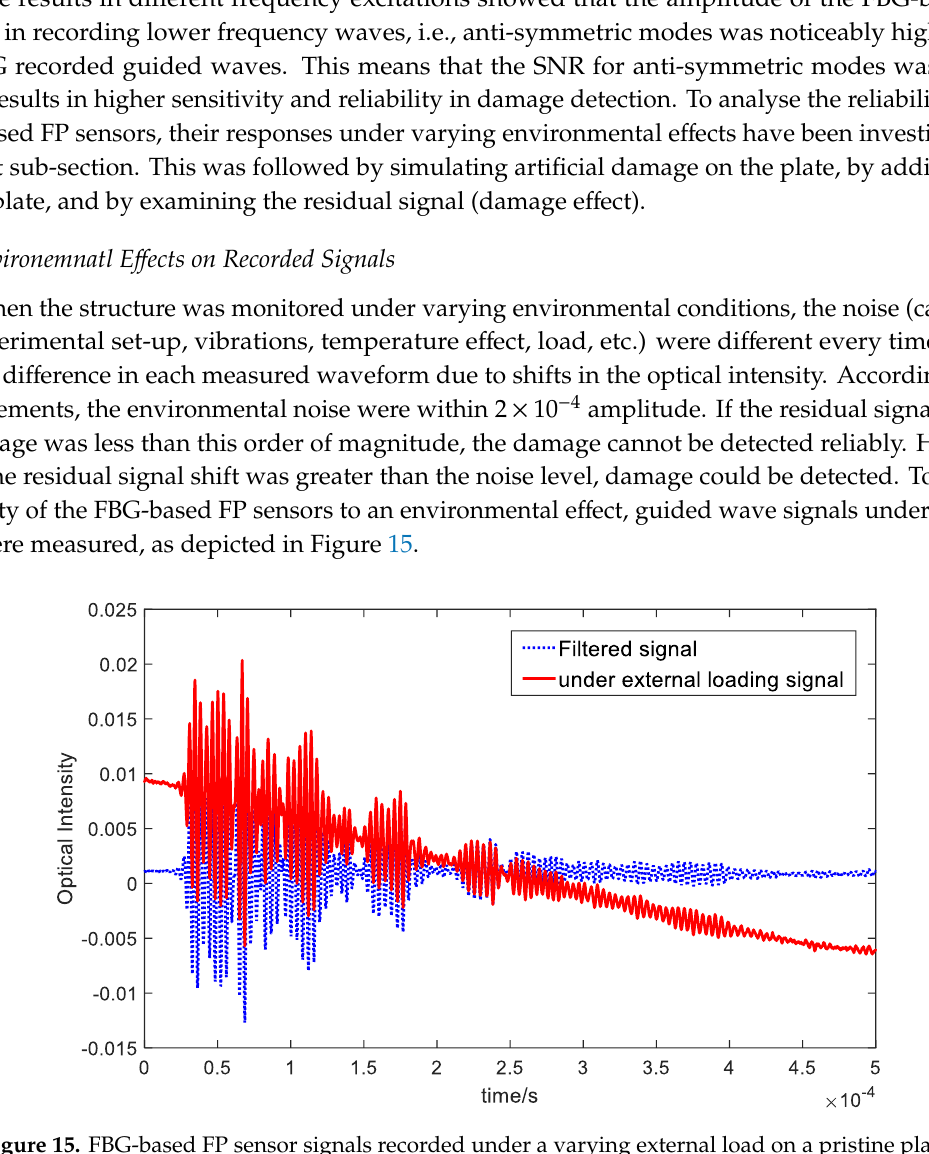
( b ) FBG sensor signal Figure 16. Processed data comparison between different environments. 4.6. Signal Acquisition – Simulated Damage To study the sensitivity of the FBG-based FP sensors in detecting damage, their response under artificial damage were recorded and compared to the FBG sensor signals (which is the conventional hybrid set up). In this paper, for proof of concept, an artificial damage in the form of an additional mass was introduced onto the specimen. The added mass would change the propagation properties of the guided wave, which causes alterations to the signal in the form of refraction and reflection. Therefore, it could be used in the development stage as representative of damage in the composite plate. From the study on the pristine signals presented in Figure 14, it was observed that the response at different frequencies varies between the two sensors with the low frequency 𝐴 0 dominated wave